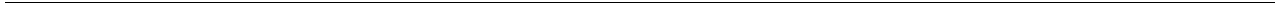
Figure 5 | Cochlear expression of Slc4a10 morphology of the lateral wall and endocochlear potential in trombone mice. ( a ) Immunohistochemical DAB staining of cochlear sections identifies Slc4a10 expression in the SL fibrocytes of Slc4a10 þ / þ and Slc4a10 þ /trmb mice. No DAB staining of Slc4a10 trmb/trmb sections is observed at any of the time points tested. Scale bar, 600 m m. Number of cochleae imaged (one per mouse) for each genotype at 2-, 6-, 9- and 12 months of age were: Slc4a10 þ / þ n ¼ 5, 5, 6, 6; Slc4a10 þ /trmb n ¼ 7, 4, 5, 6; and Slc4a10 trmb/trmb n ¼ 4, 3, 5, 6, respectively. ( b ) SGN counts in Slc4a10 þ / þ , Slc4a10 þ /trmb and Slc4a10 trmb/trmb mice shows there are no differences across genotype, or with age. Counts averaged from individual mice ( N ¼ 3) for each genotype at each age. ( c ) Analysis of the cross-sectional surface area of the SL shows there are no differences across genotypes, or with age. ( d ) Analysis of the SV show there is a significant reduction in the cross-sectional surface area in Slc4a10 trmb/trmb mice compared with Slc4a10 þ / þ and Slc4a10 þ /trmb mice, and this is consistent across the ages tested. The SL and SV surface areas are averaged from individual mice for each genotype at 2-, 6-, 9- and 12 months of age: Slc4a10 þ / þ n ¼ 5, 3, 5, 5; Slc4a10 þ /trmb n ¼ 7, 5, 8, 5; and Slc4a10 trmb/trmb n ¼ 5, 6, 7, 6, respectively. ( e , f ) Comparison of SL and SVnuclei counts shows there are no differences across genotype, or with age. The nuclei counts are averaged from individual mice for each genotype at 2-, 6-, 9- and 12 months of age: Slc4a10 þ / þ n ¼ 5, 3, 3, 3; Slc4a10 þ /trmb n ¼ 5, 4, 4, 3; and Slc4a10 trmb/trmb n ¼ 6, 5, 4, 3, respectively. ( g )